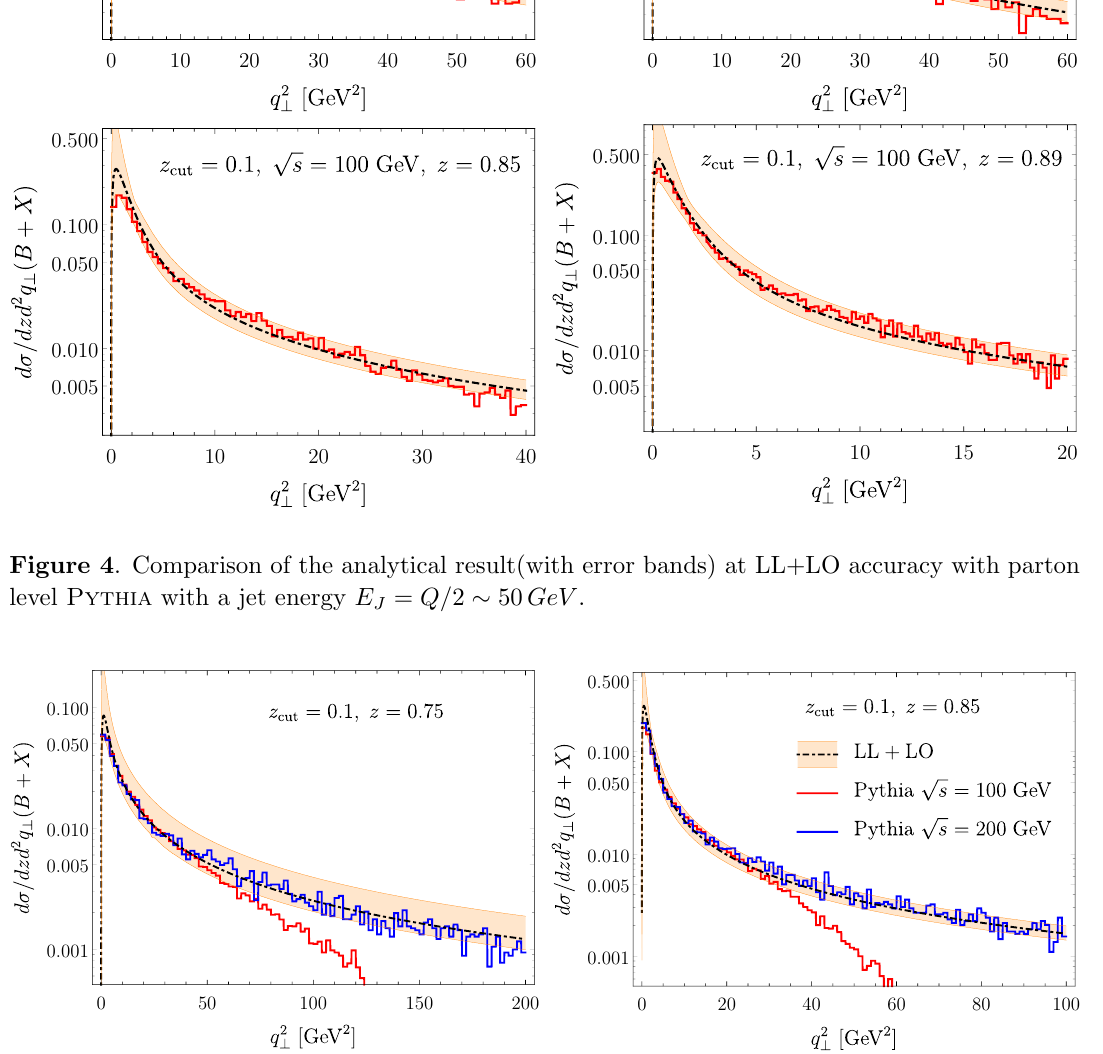
Figure 5 . Comparison with parton level Pythia for di(cid:11)erent values of jet energy E the jet energy increases, the EFT is valid till a higher value of q the Q independence of the shape at low q